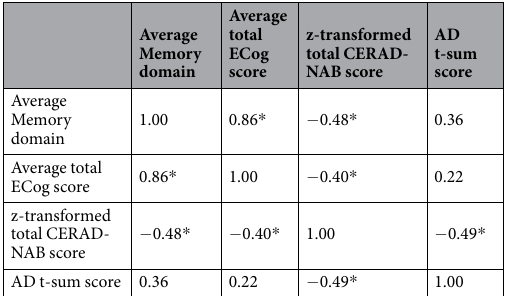
Table 4. Pairwise correlation analysis between average memory domain of ECog, average total ECog, z-transformed CERAD-NAB score and PALZ scores in patients with early stage of probable AD. Abbreviations: ECog, Everyday Cognition; CERAD-NAB, Consortium to Establish a Registry for Alzheimer’s Disease Neuropsychological Assessment Battery; AD, Alzheimer’s disease. Tested by spearman’s rank correlation. * P <